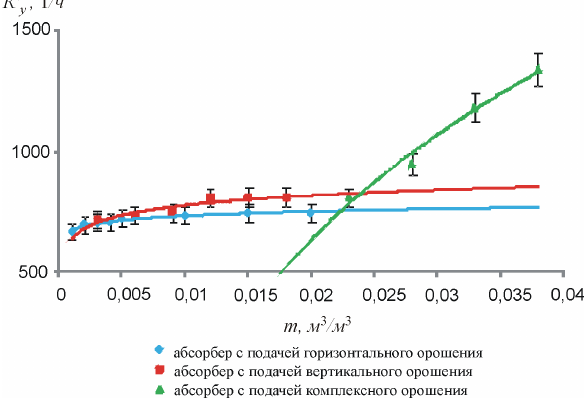
Рис. 6. Зависимость условного объемного коэффи- циента абсорбции от удельного орошения при разных Fig. 6. Dependence of notional volume ratio of absorption on specific irrigation under various types of sprinkling supply ( g ν = 0.14